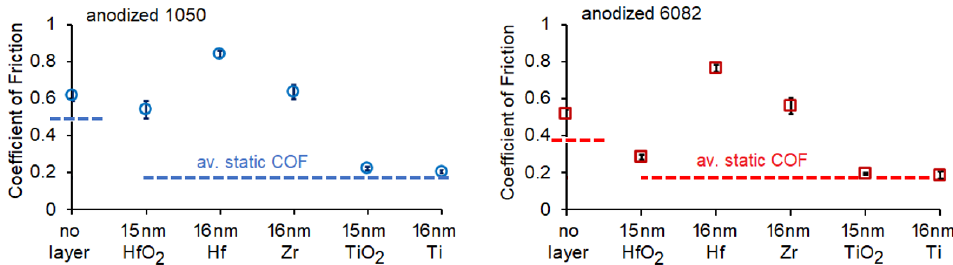
Figure 4. Influence of nanolayers of group IVB elements on friction after 10 cycles deposited on anodized 1050 ( left ) and 6082 ( right ) alloys, adapted with permission from [18]. 2021, Elsevier